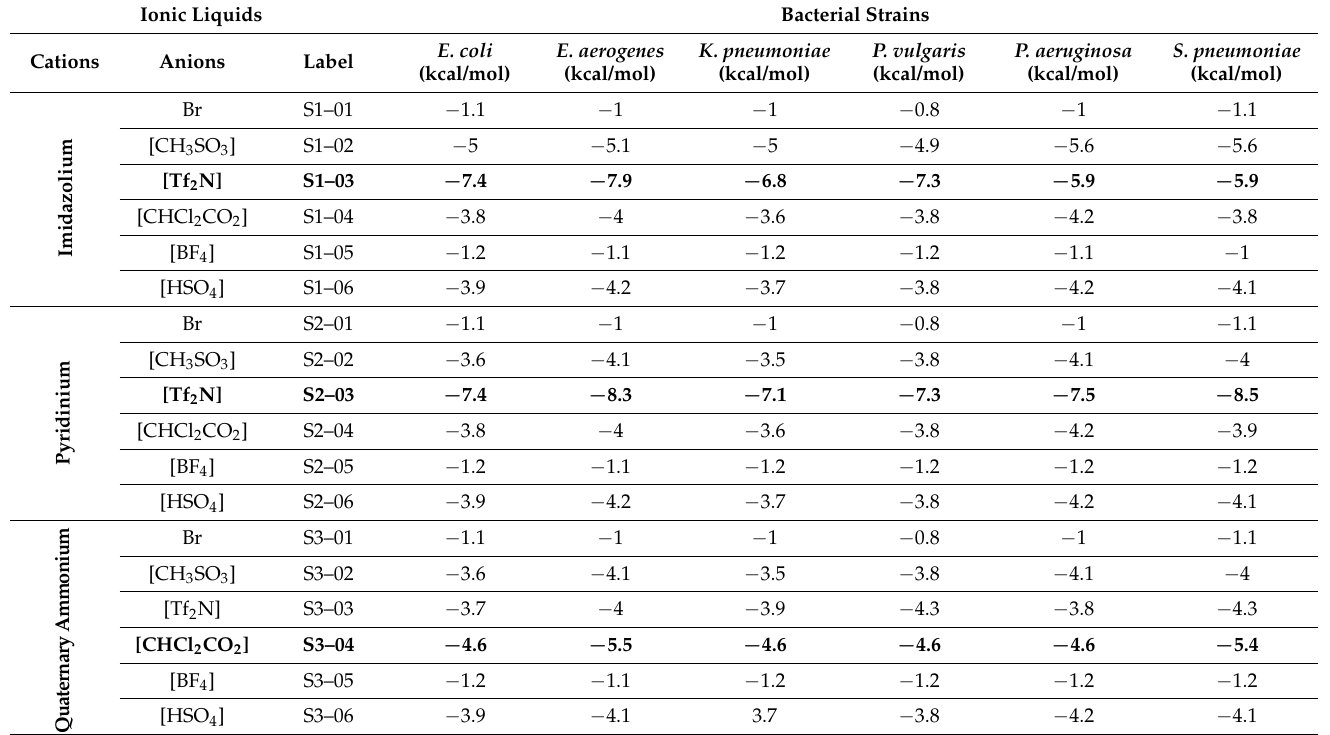
Table 2. Protein–ligand binding energy of ILs with Beta Lactamase protein against six different bacterial